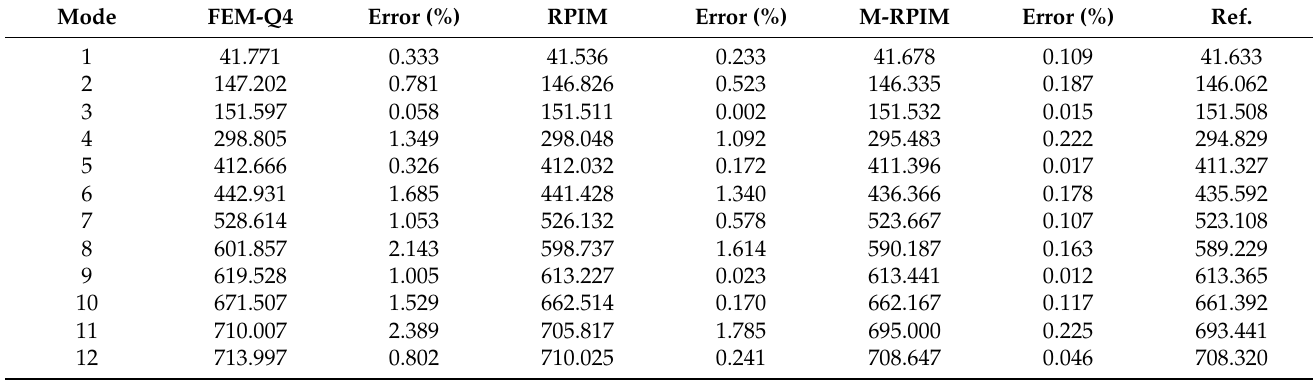
Figure 7. The geometric configuration of the variable cross-section beam in plane stress condition. Table 5. The first twelve natural frequency values for the variable cross-section cantilever beam computed using different numerical